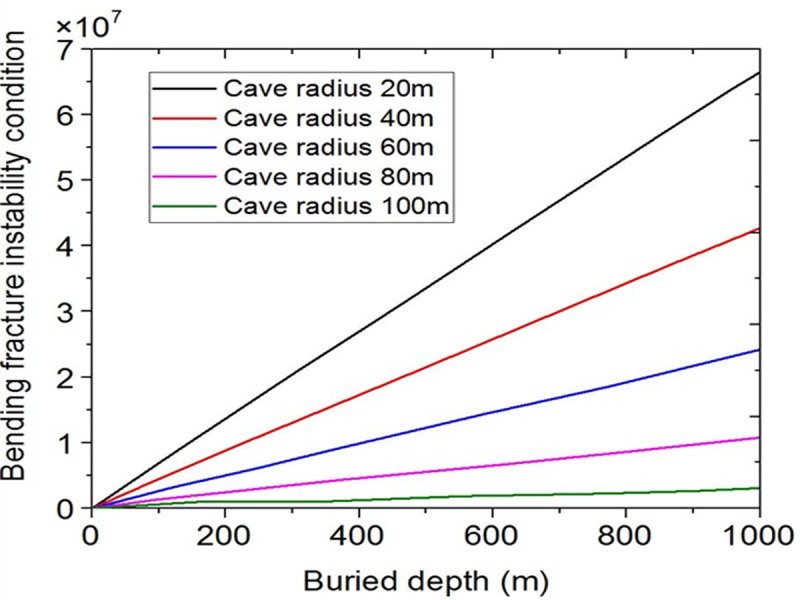
Influence curves of different cave radius.